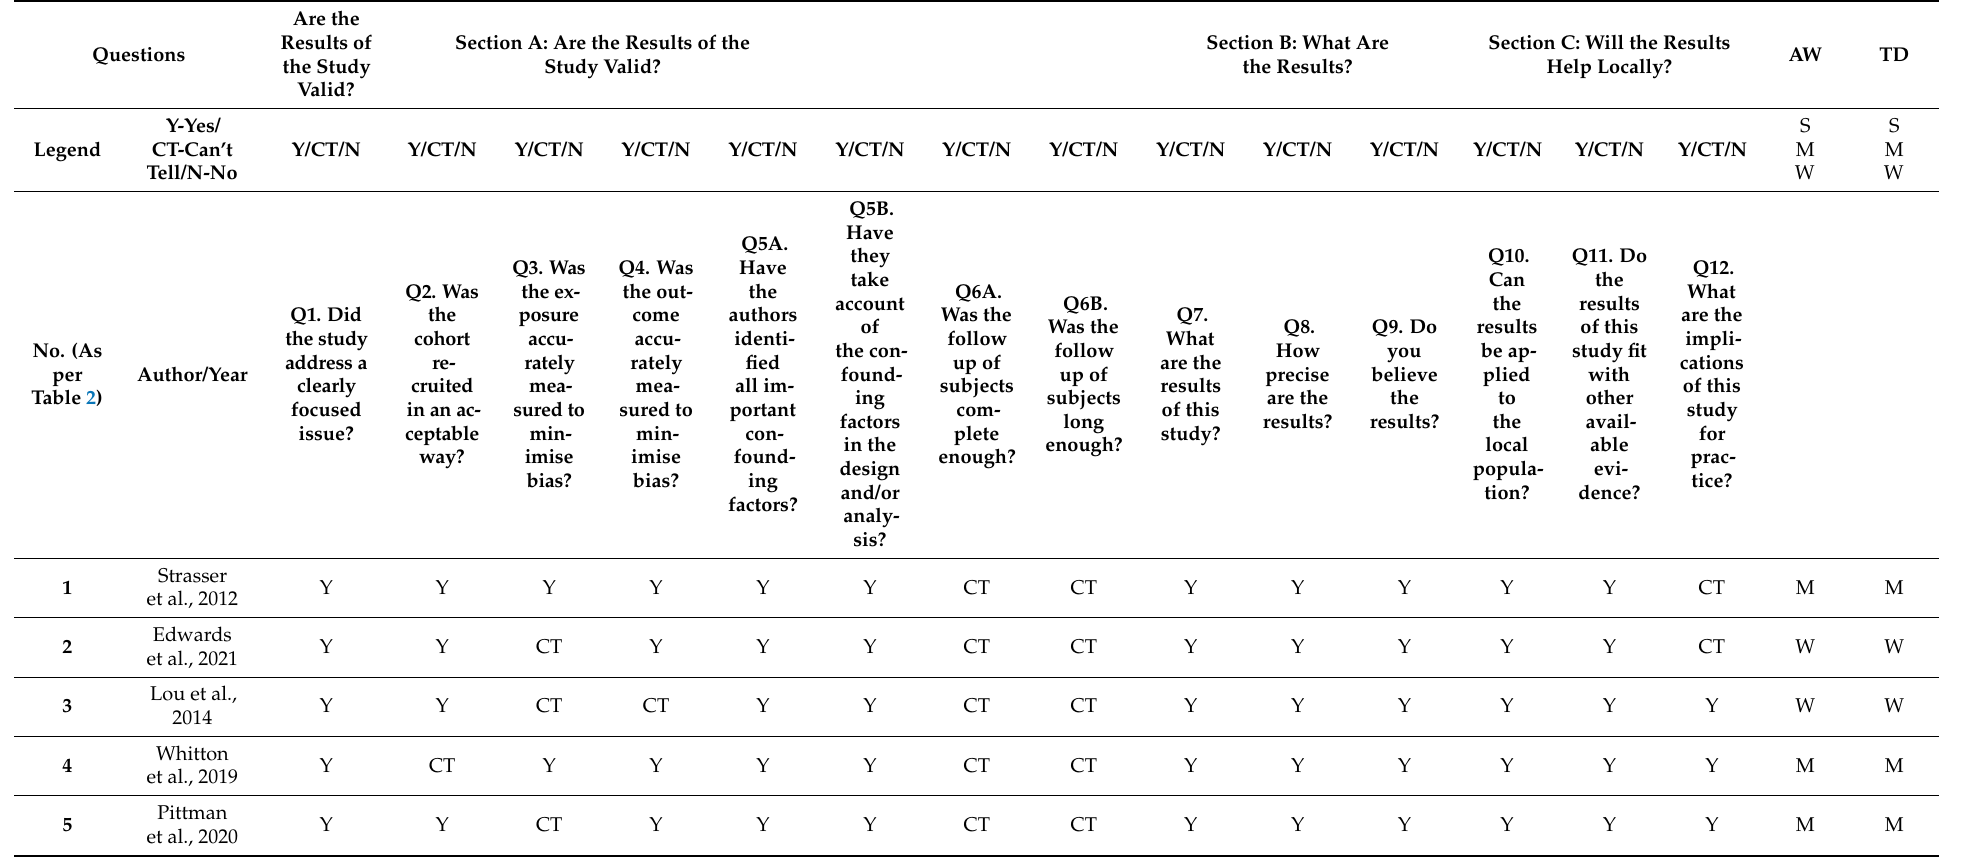
Table 3. CASP Cohort